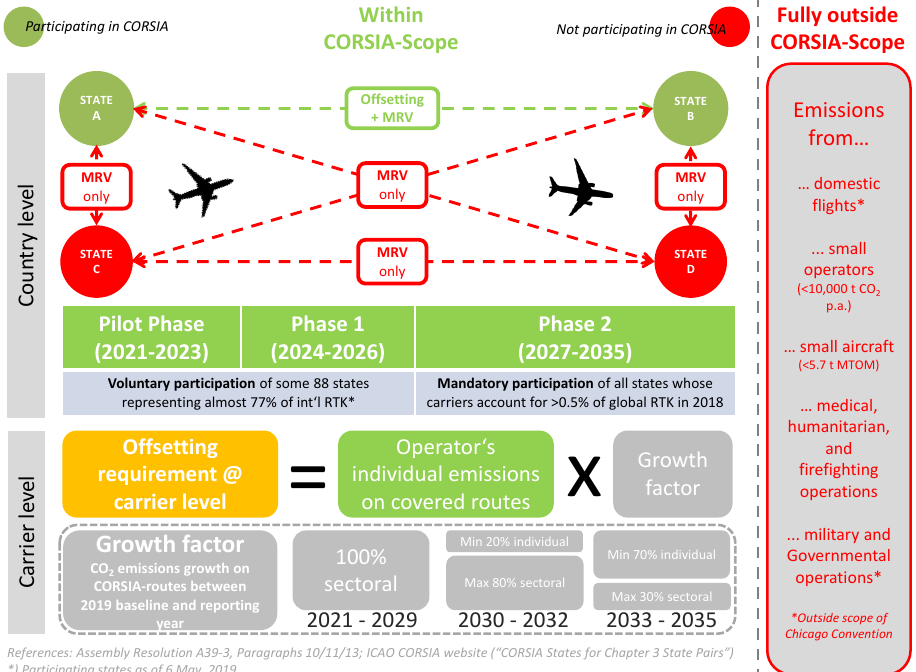
Figure 1. Principal design of the Carbon Offsetting and Reduction Scheme for International Aviation (CORSIA). Notes: This figure highlights the principle design of CORSIA in 2021. Source: Own Figure Maertens et al., Options to Continue the European Union Emissions Trading System for Aviation in a CORSIA-World, Sustainability,